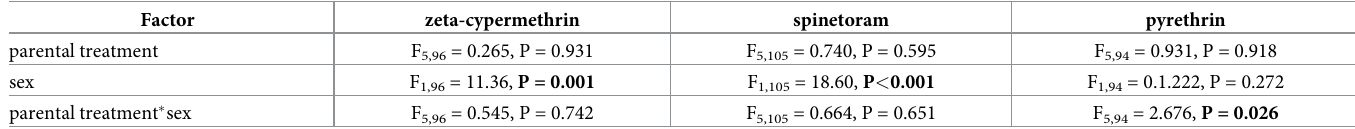
Table 5. Two-way ANOVA results for the impacts of sex and parental exposure to zeta-cypermethrin, spinetoram, or pyrethrin on adult F1 mortality after exposure to a diagnostic dose. Bolded values indicate statistically significant p-values (P-value �